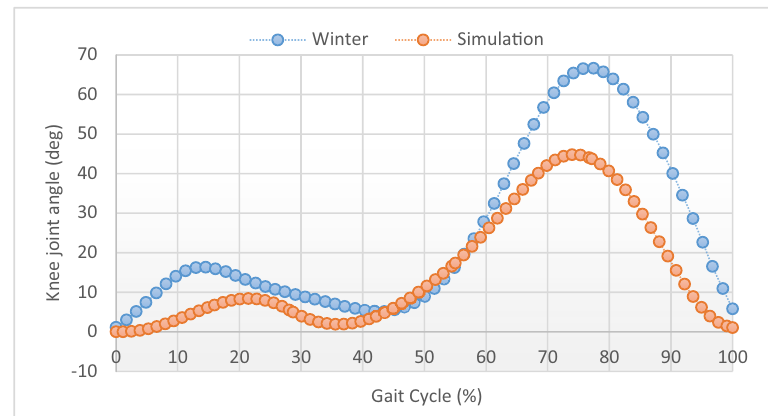
Figure 16: Comparison between model and healthy leg: knee joint angle vs gait